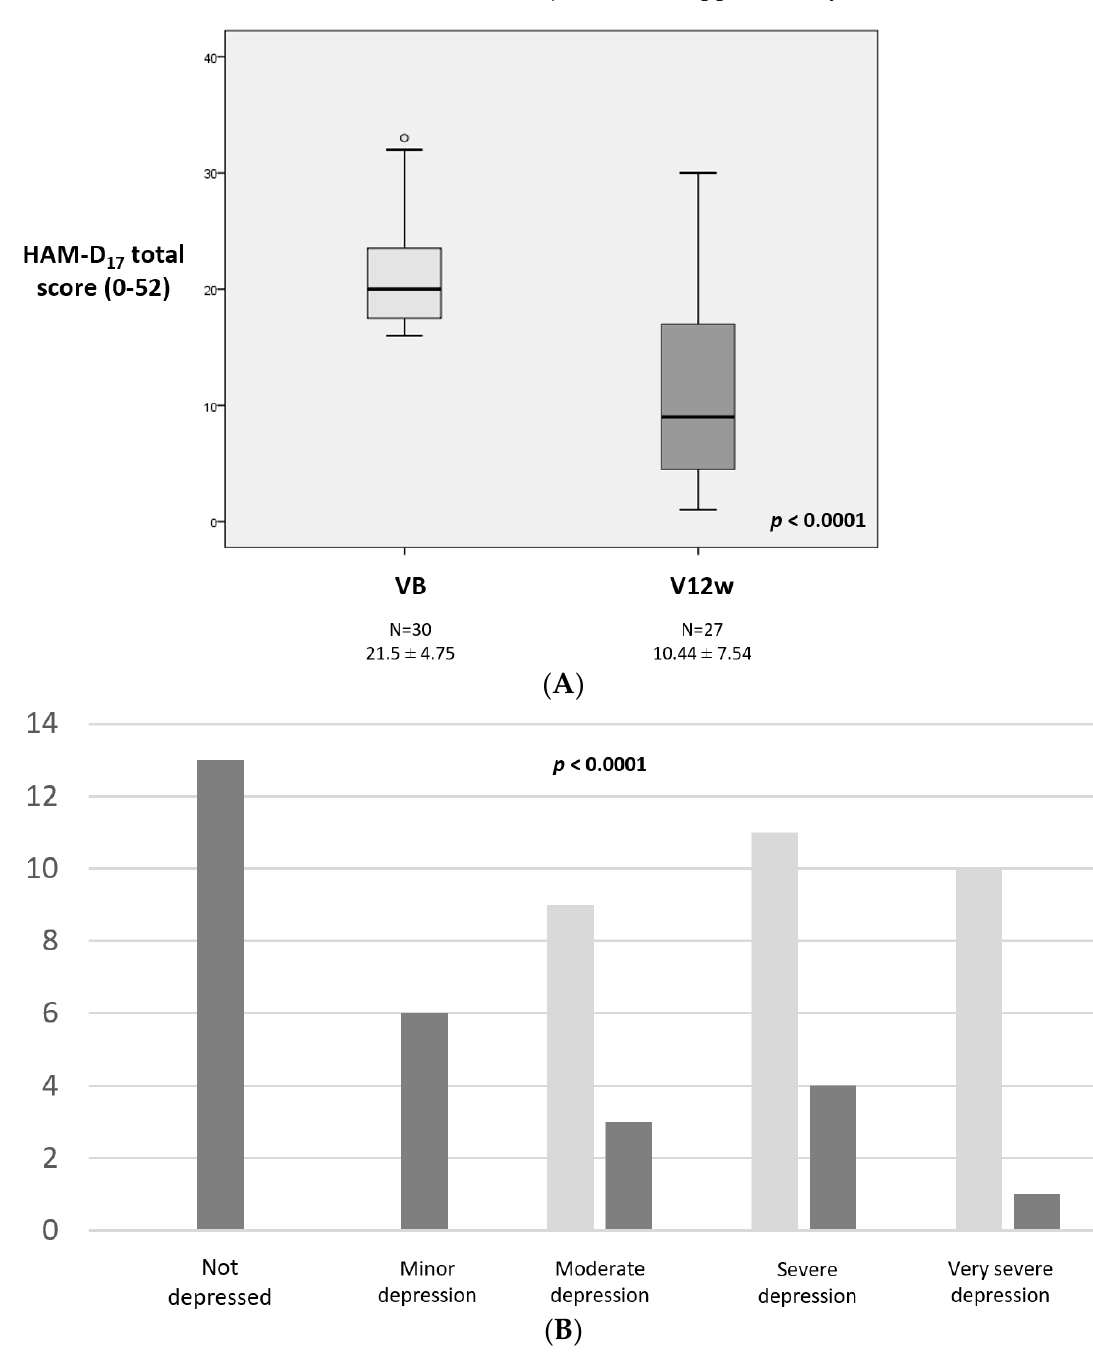
Figure 1. ( A ) HAM ‐ D17 total score at VB (baseline) and V12w (12 weeks ± 14 days); p < 0.0001. ( B ) Number of cases with different type of depression at VB vs V12w: not depressed, HAM ‐ D17 0–7; mild/minor depression, HAM ‐ D17 8–13; moderate depression, HAM ‐ D17 14–18; severe depression, HAM ‐ D17 19–22; very severe depression, HAM ‐ D17 > 23 ( p < 0.0001). Data are presented as box plots, with the box representing the median and the two middle quartiles (25–75%). p values were computed using the Wilcoxon signed-rank test ( A ) and the marginal homogeneity test ( B ). Mild outliers (O) are data points that are more extreme than Q1–1.5. HAM-D17—17-item Hamilton Depression Rating Scale.